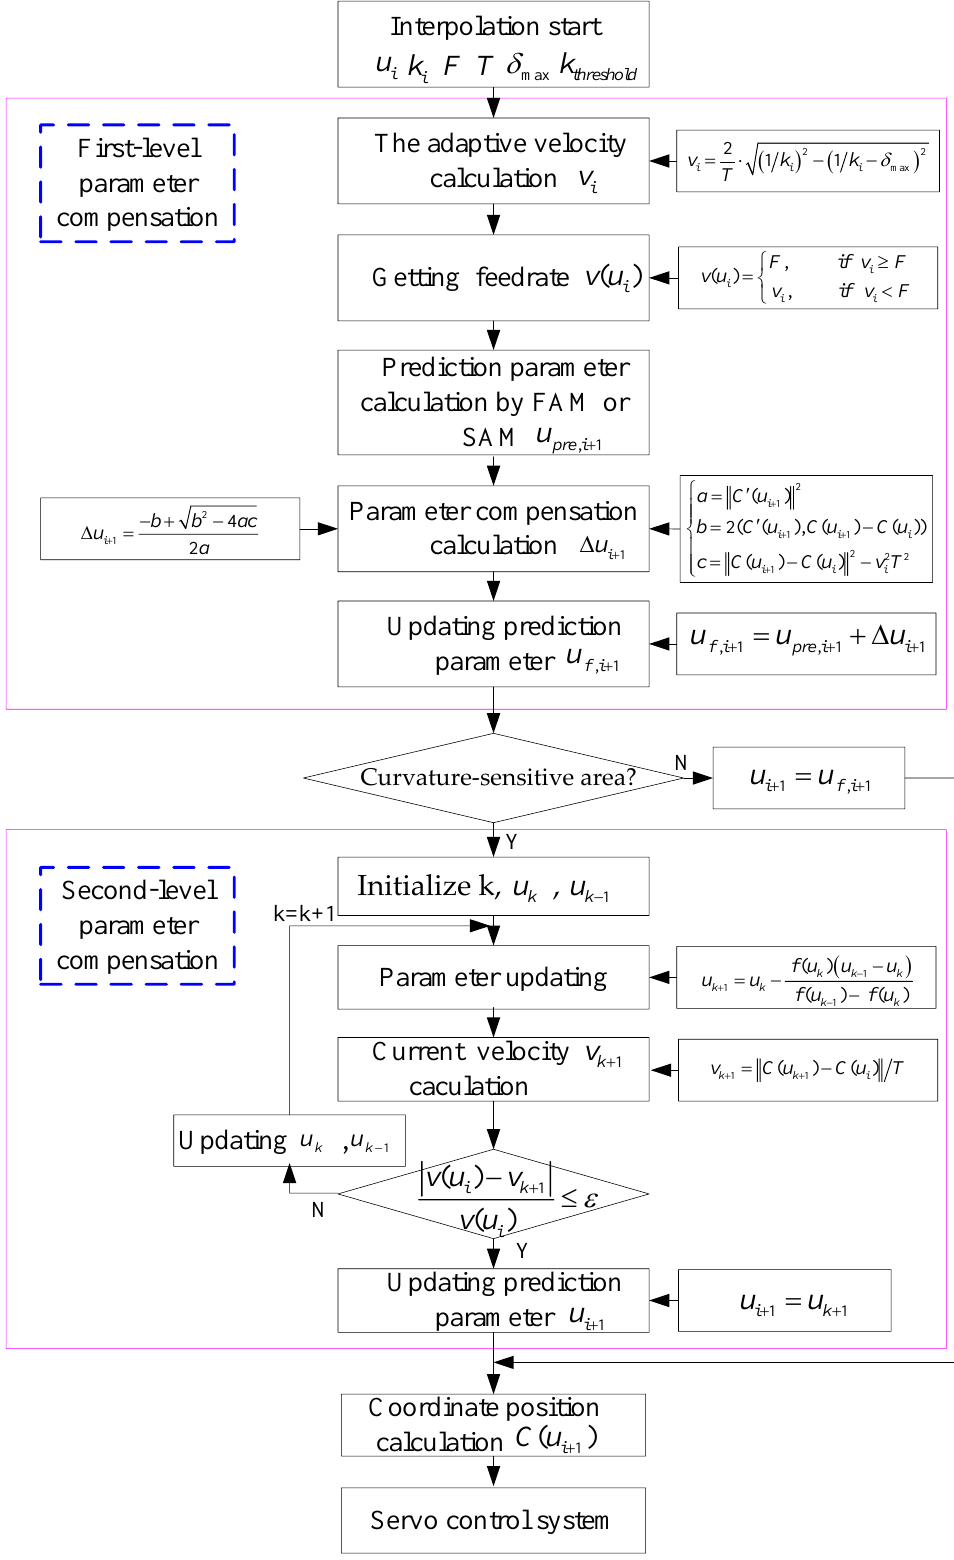
Figure 2. The flowchart of the parameter compensation.